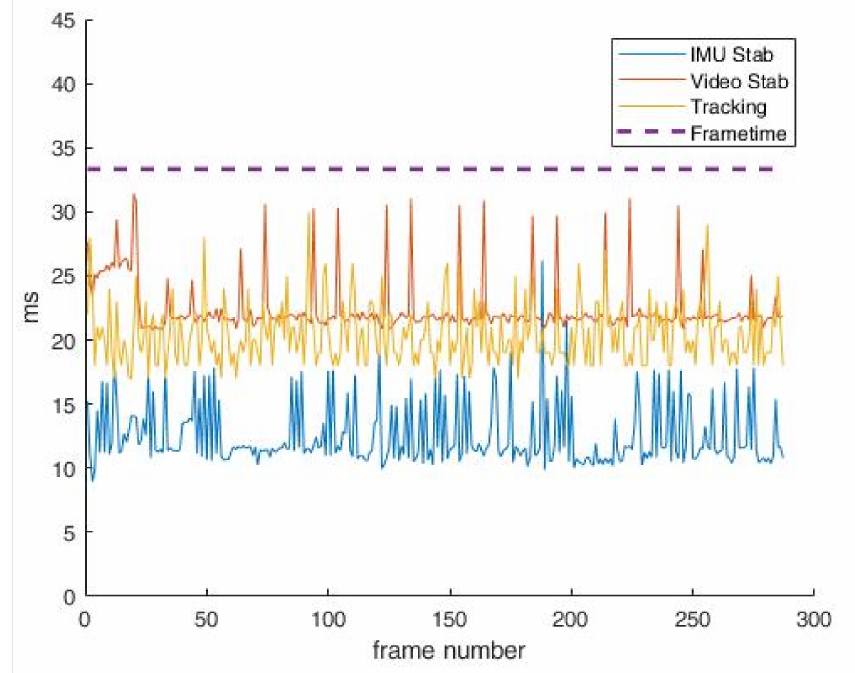
Figure 18. Algorithms’ execution times at video stream of 30 fps in FullHD.